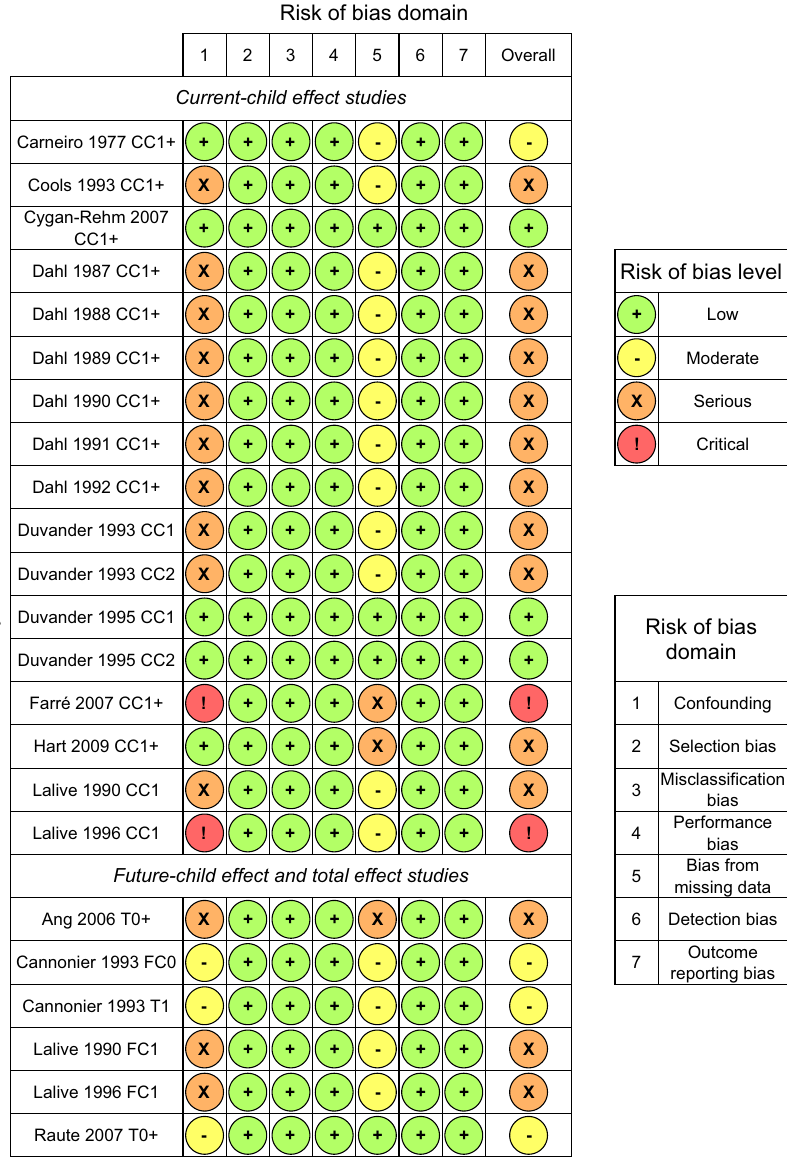
Fig. 4 ROBINS-I evaluations of included studies. Study references are the same as those in the “ Study key ” column of Table 2. Figure adapted from visualisations produced by the R package “ robvis ” (McGuinness and Higgins,